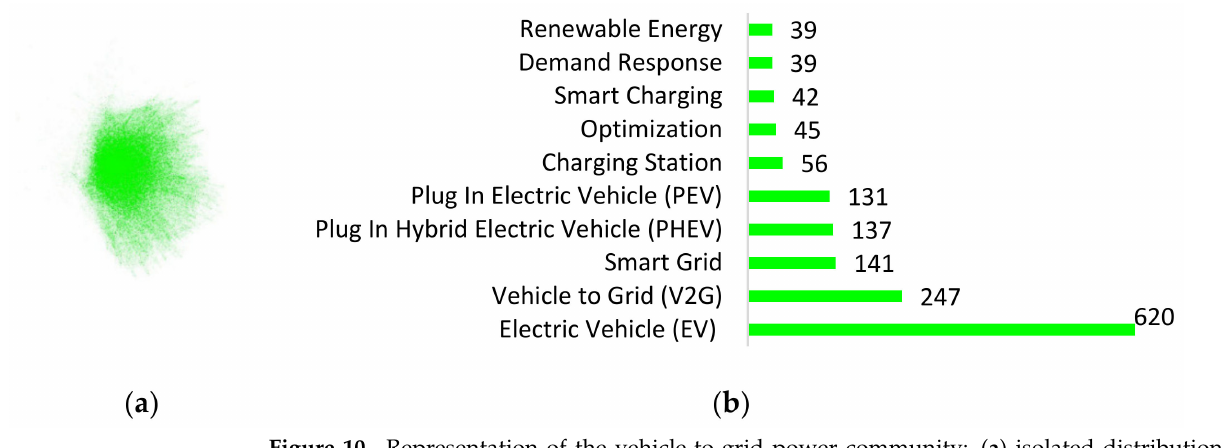
Figure 10. Representation of the vehicle-to-grid power community: ( a ) isolated distribution of publications; ( b )